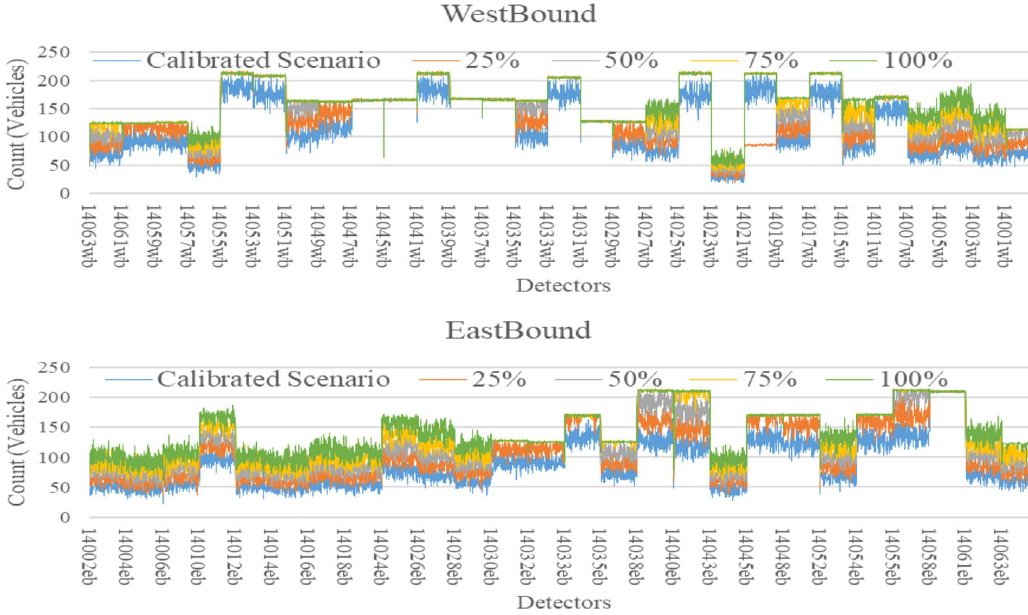
Figure 10. Future count data generated from Aimsun.